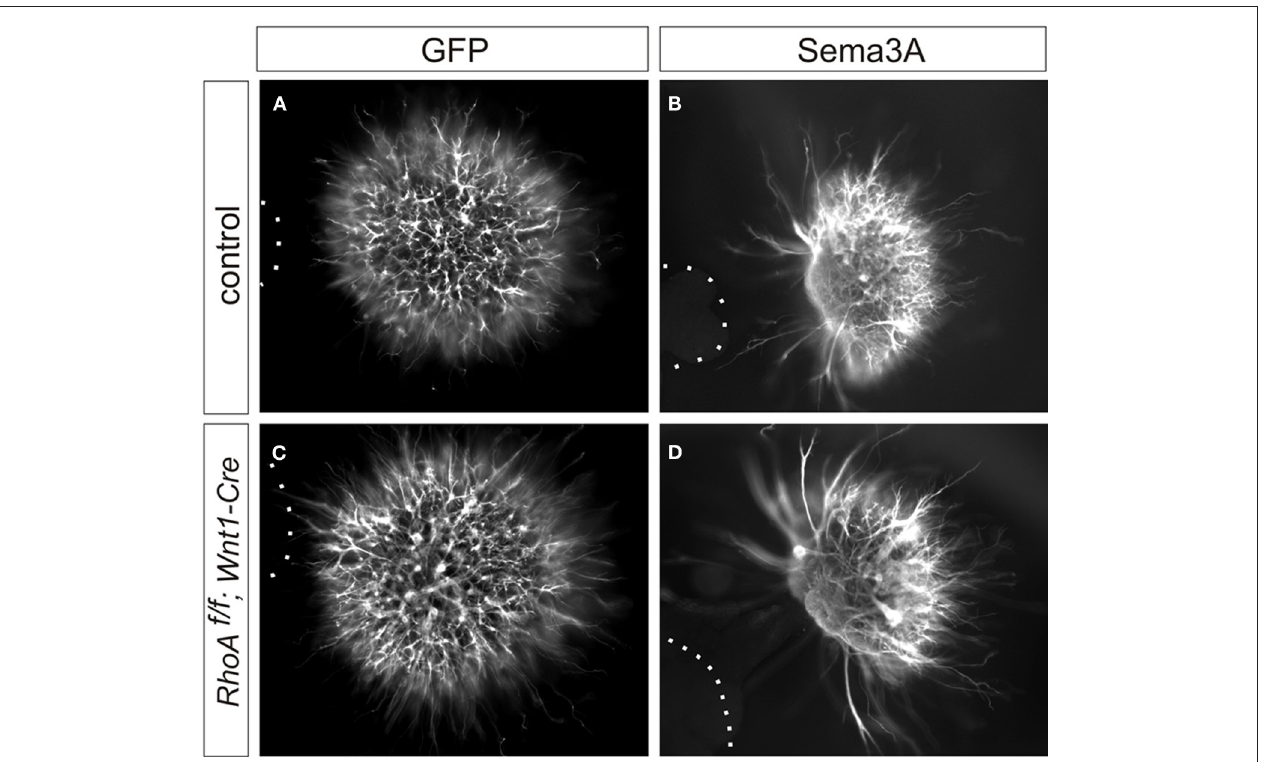
axons of DRG neurons were examined by anti-TuJ1 antibody. Both DRG axons from control and RhoA f / f ; Wnt1-Cre embryos were repelled by Sema3A. Dotted lines outline aggregates of 293T cells.